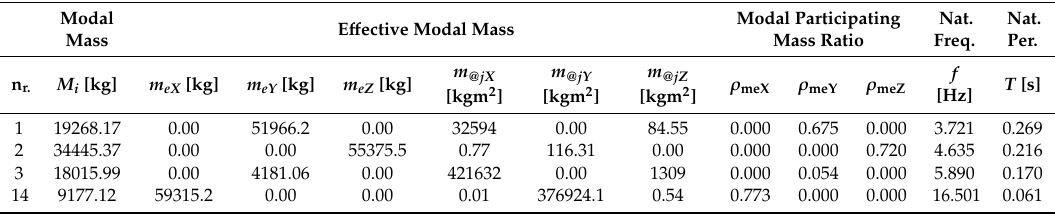
Table 4. Results of the modal analysis after the second model update ( m eX , m eY , m eZ : Table 5. Verification of comfort criteria ( T : period; f : frequency; M : total mass of the bridge;  damping ratio).